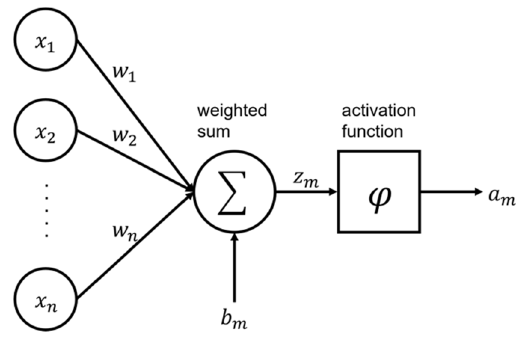
Figure 5. An output computation at a single node.